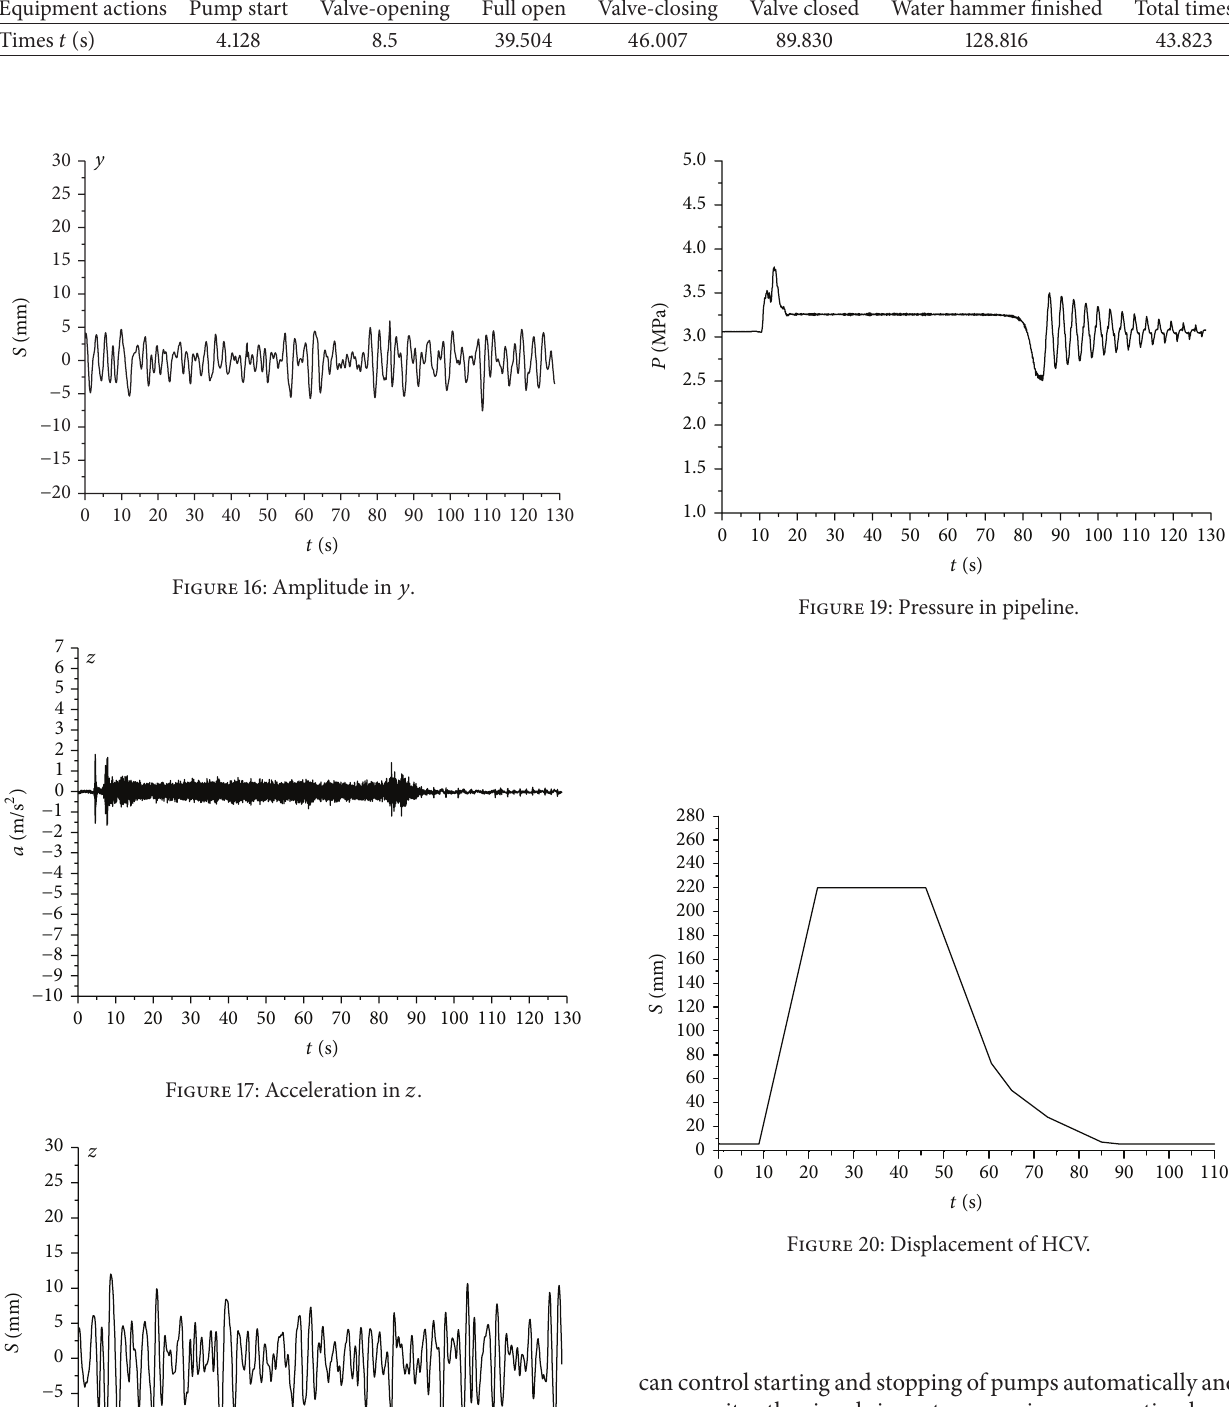
Figure 17: Acceleration in 𝑧 .